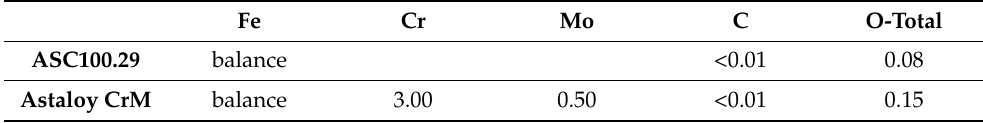
Table 1. Nominal chemical composition of the base powders used in this study (wt%)